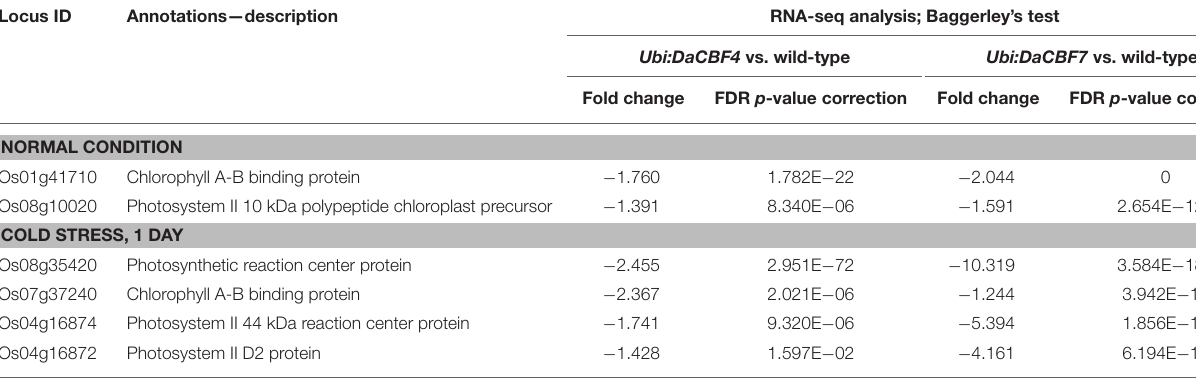
TABLE 2 | List of differentially down-regulated genes belonging to GO term “Photosynthesis” (GO:0015979) in both transgenic rice plants Ubi:DaCBF4 and Ubi:DaCBF7 under normal control or cold stress condition when compared to wild type plants. Locus ID